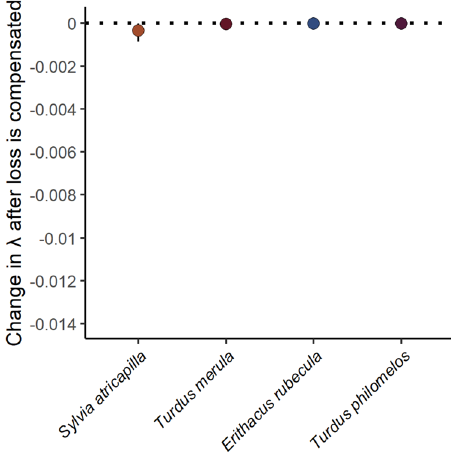
Fig. 4 Interaction compensation after frugivore loss. Projected consequences of the extinction of each of the four main frugivorous animals on population growth of F. alnus assuming complete interaction compensation after their loss (i.e., a species is lost, but the remaining animal community compensates interactions). Mean ± 95% prediction intervals based on 500 bootstraps of dispersal